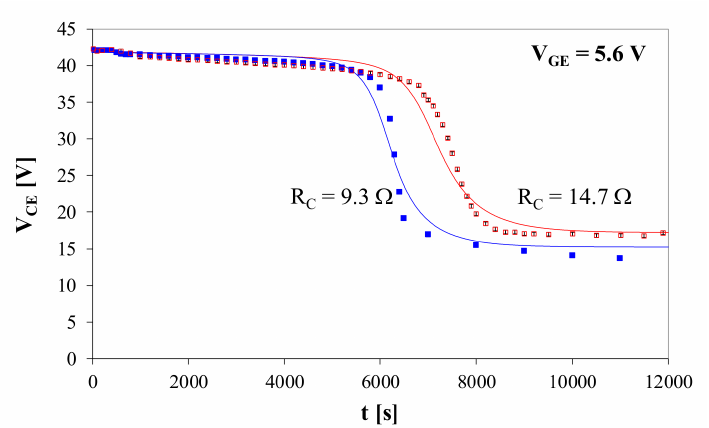
Figure 6. Measured and calculated waveforms of V CE voltage of the IGBT.